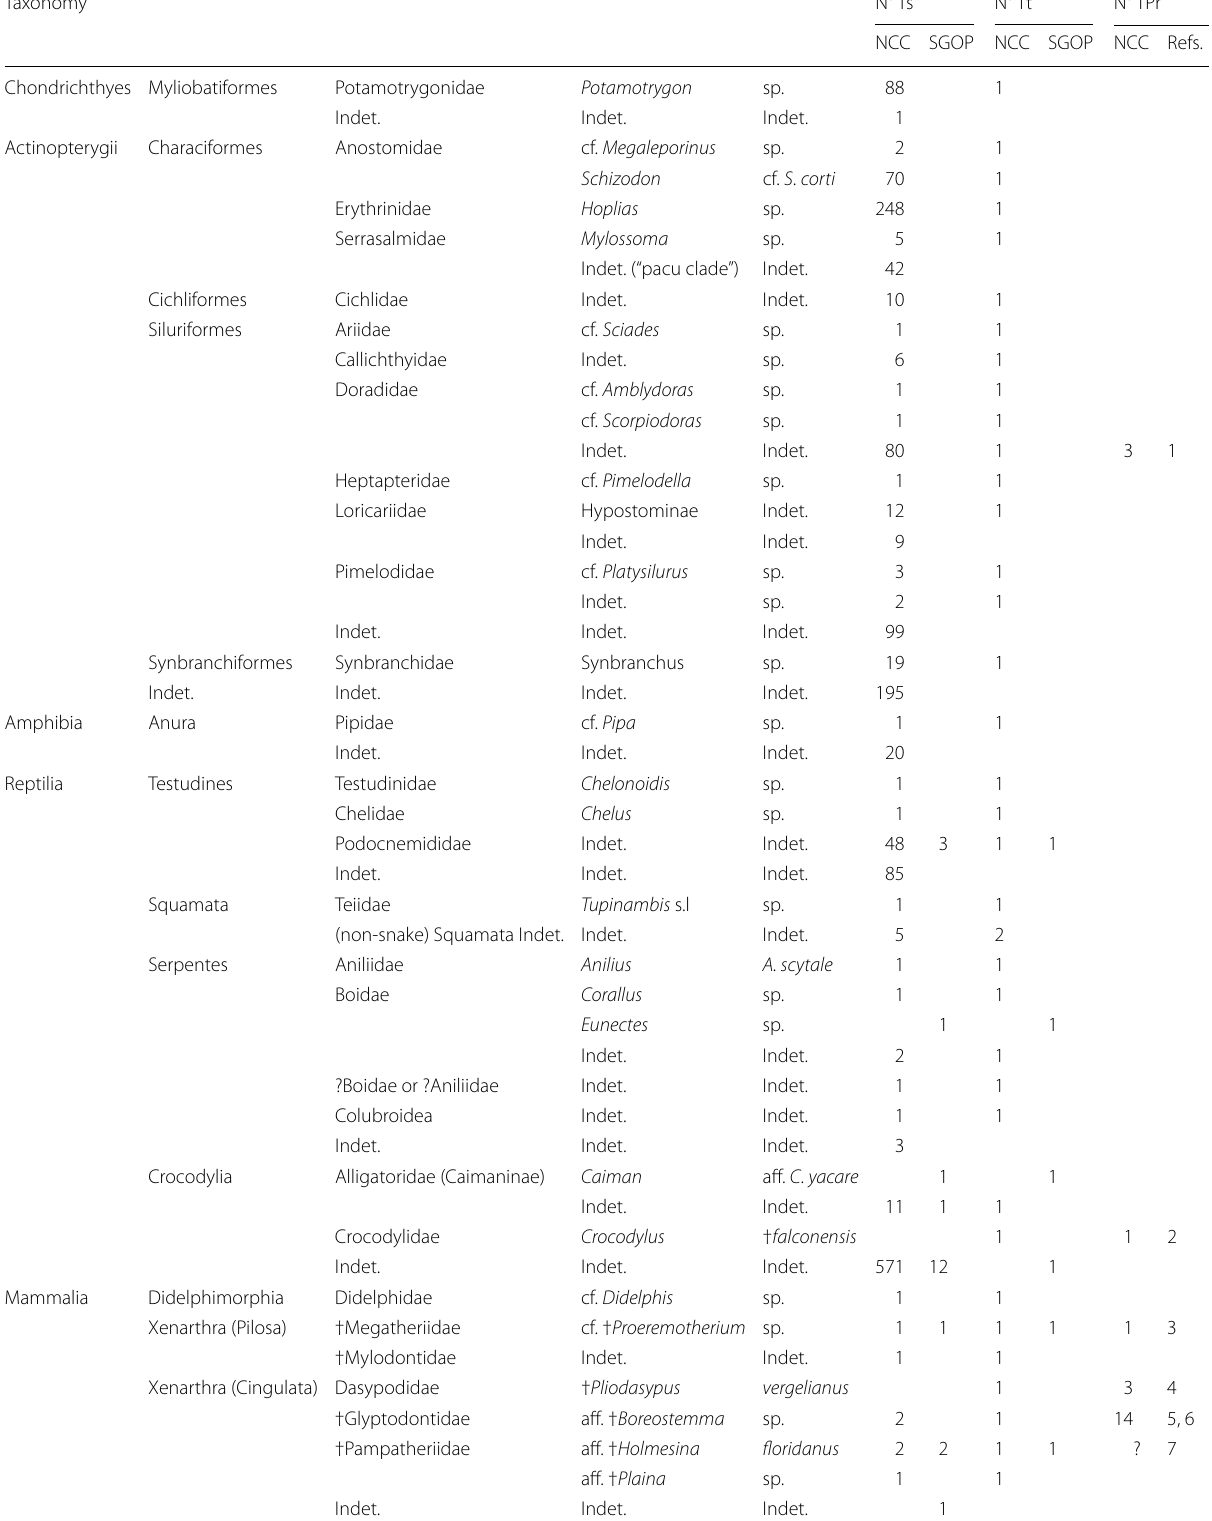
Table 1 Vertebrate paleodiversity of the San Gregorio Formation